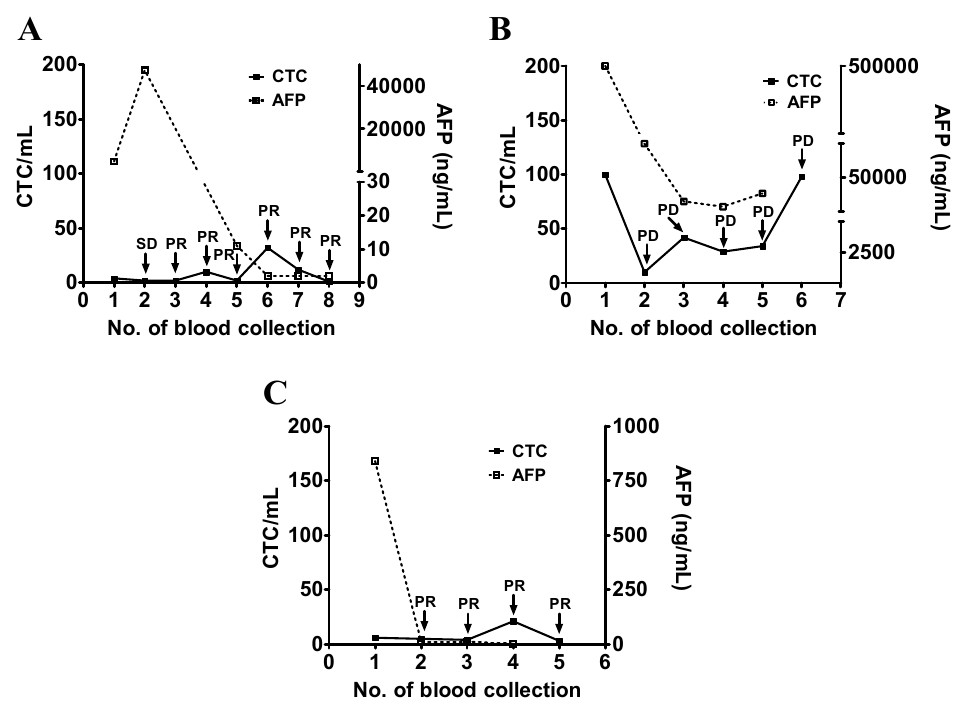
Figure 3. Longitudinal follow-up of the CTC counts for monitoring the disease status of patients with HCC (part I). ( A – C ) The blood samples were longitudinally collected from patients #1 (panel A ), #17 (panel B ), and #19 (panel C ), who had a high initial serum AFP level followed by a decrease. Series testing of the CTC count and the serum AFP level were performed and plotted accordingly. The disease status (SD, PR, and PD) was determined and was used as an indicator of the patient’s clinical outcome.